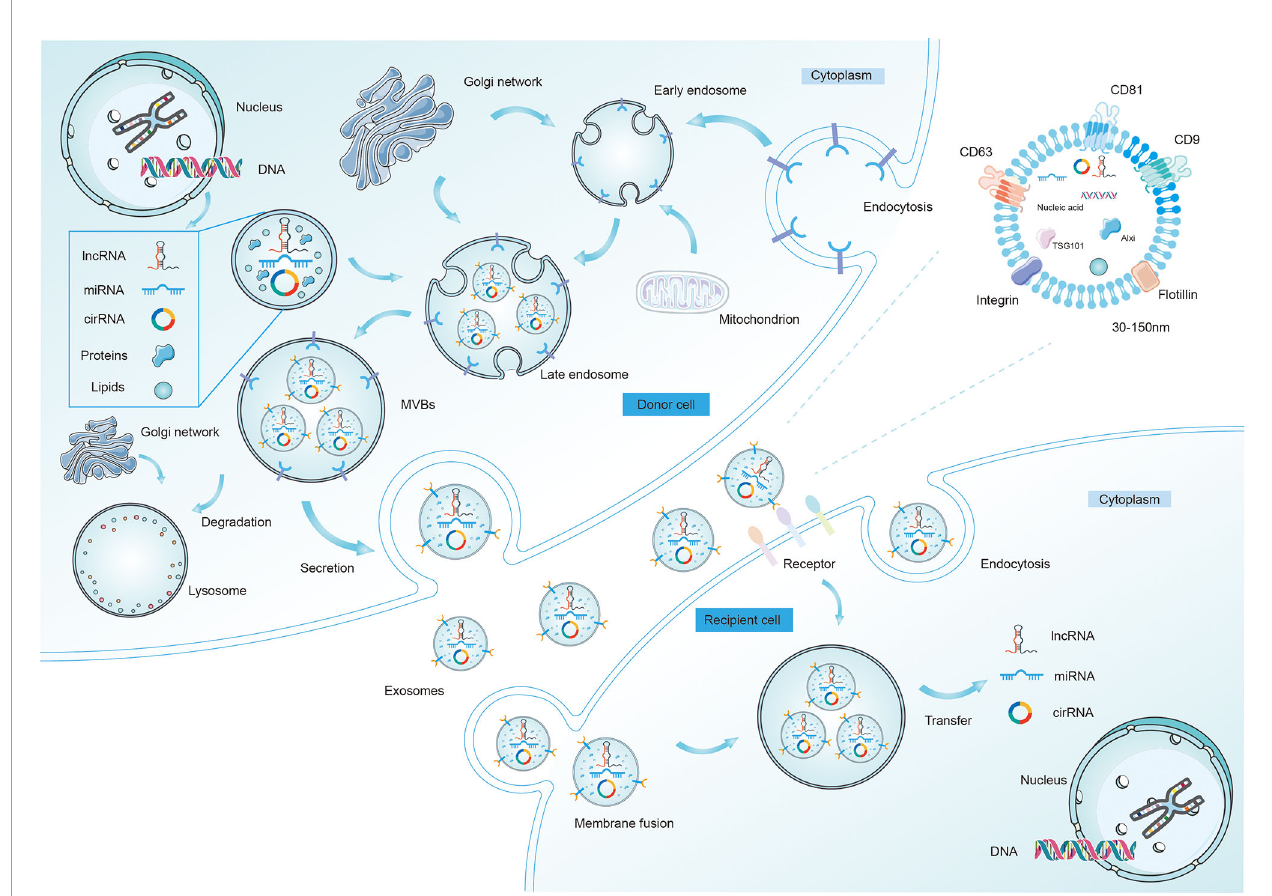
FIGURE 1 | The biogenesis, release, and characteristics of exosomes. The formation and release of exosomes is a multi-step process. First, it begins with early endosome formation through endocytosis of the plasma membrane, followed by formation of the late endosome with different ncRNAs, lipids, and proteins inside. Second, the late endosomes undergo multiple depressions and bud inward to form microvesicles, thus transforming into multi-vesicular bodies (MVBs), which then may be degraded by lysosomes or fuse with the cell membrane and are released into the extracellular space as exosomes. After being secreted from donor cells into extracellular matrix, exosomes can be taken up by recipient cells and regulate the behaviors of the recipient cells by transferring regulatory non-coding RNAs (mainly miRNAs, lncRNAs, and circRNAs). Exosomes enter recipient cells in three ways, which are fusion, endocytosis, and receptor interactions. Several proteins are used as markers for exosomes (CD9, CD63, CD81, fl otillin, integrin). Exosomes (30-150nm) also contain different intracellular proteins (such as TSG101 and Alix), RNAs, DNAs, and